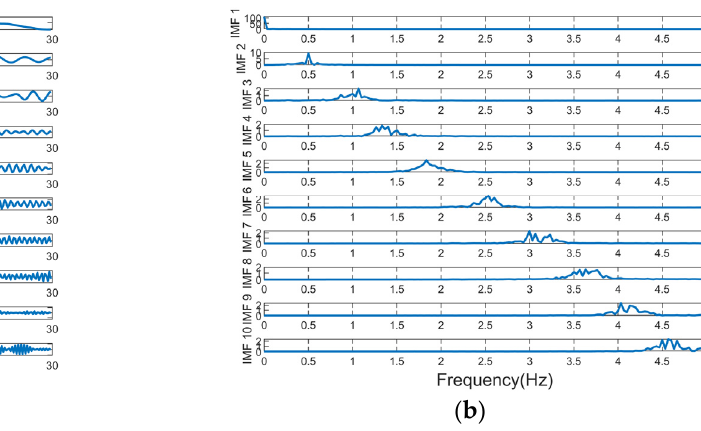
Figure 9. The BLIMFs waveform and frequency spectrum waveform of each BLIMF after decom- position of DA-VMD. ( a ) Time domain waveform of BLIMFs; ( b ) frequency spectrum waveform of each